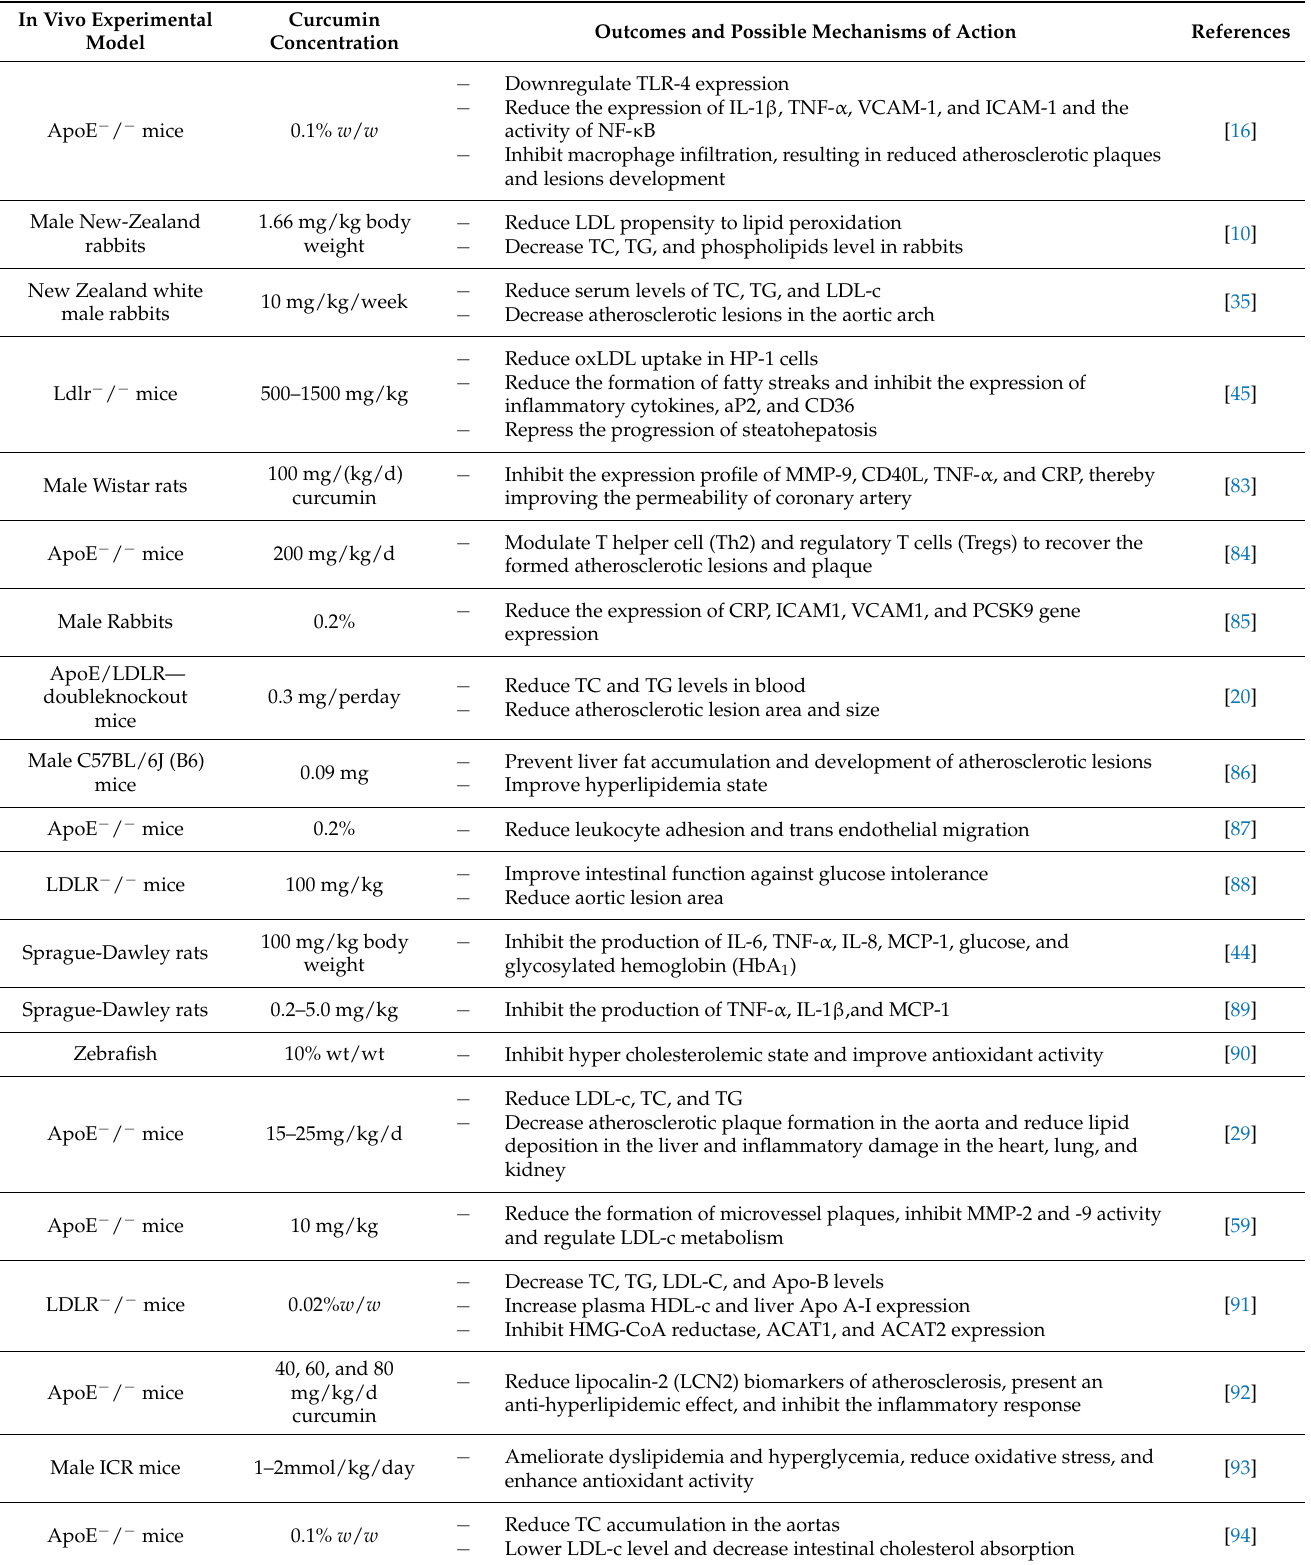
Table 2. In Vivoevaluation of the pharmacological properties of curcumin against atherosclerosis. In Vivo Experimental Curcumin Outcomes and Possible Mechanisms of Model Concentration